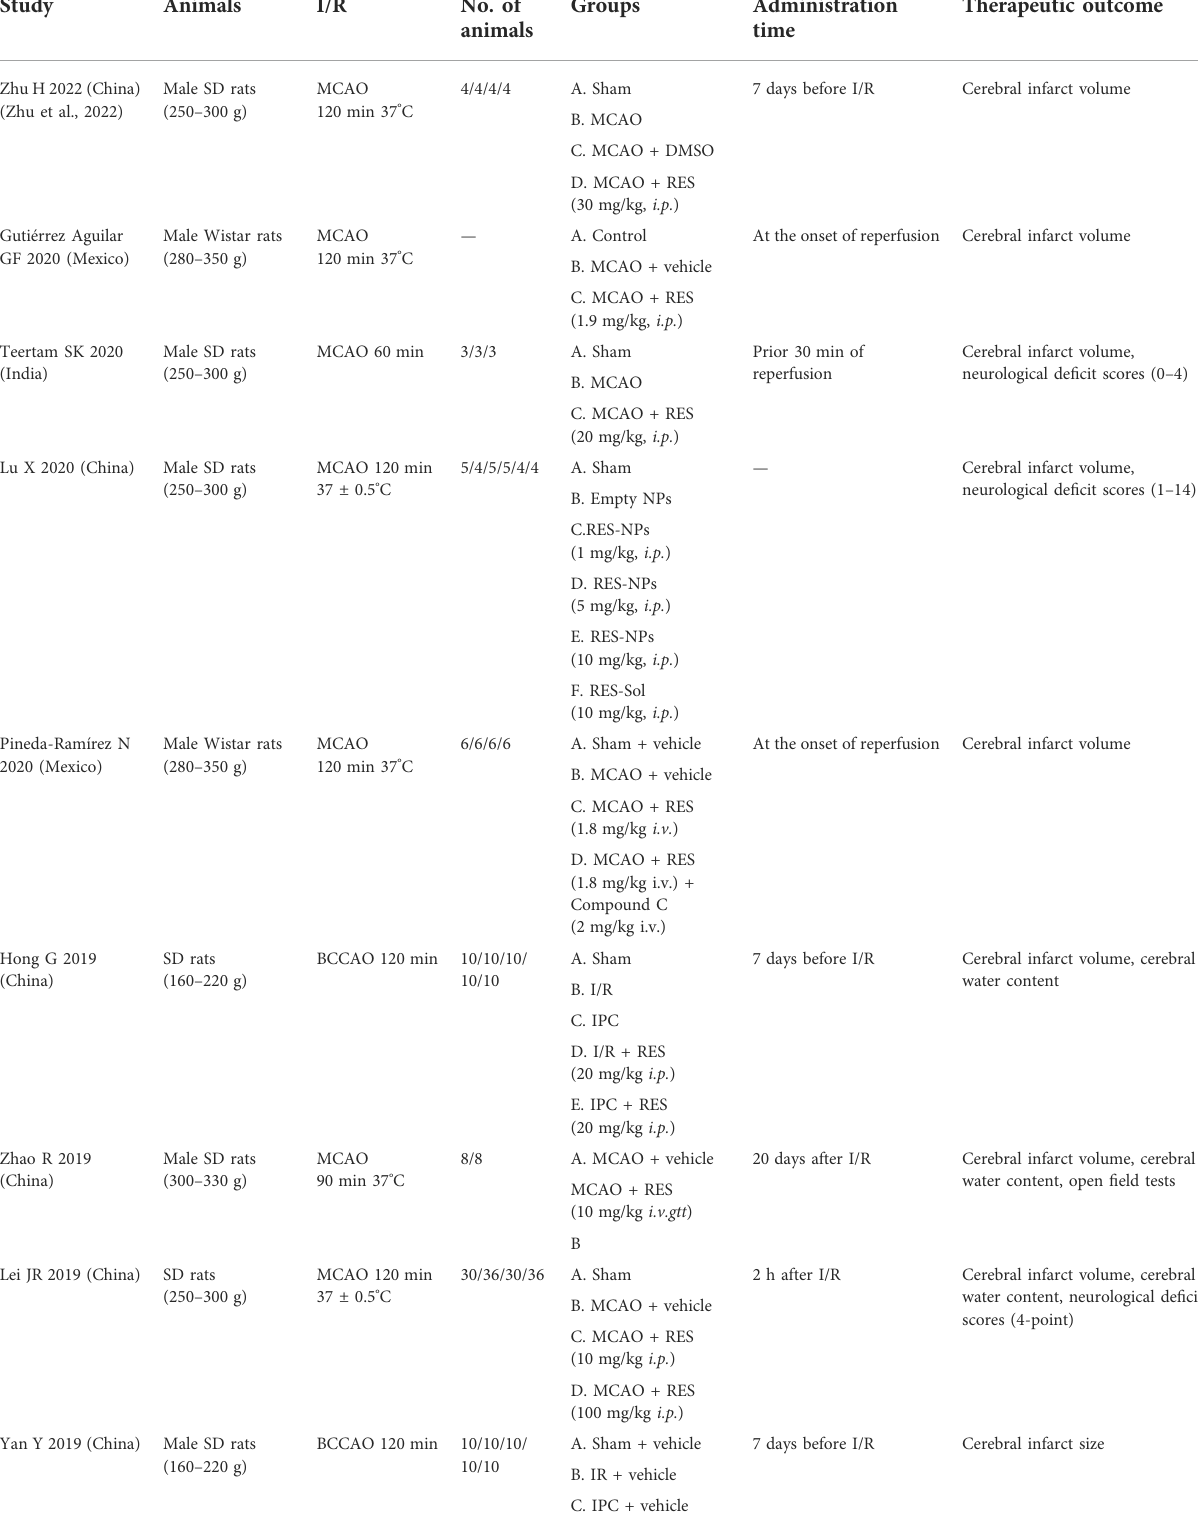
TABLE 1 Description of the characteristics of studies included in this review.